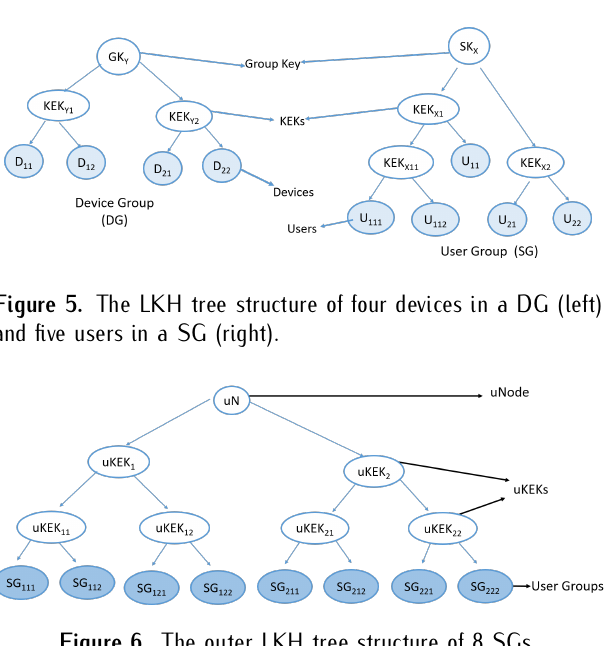
Figure 6. The outer LKH tree structure of 8